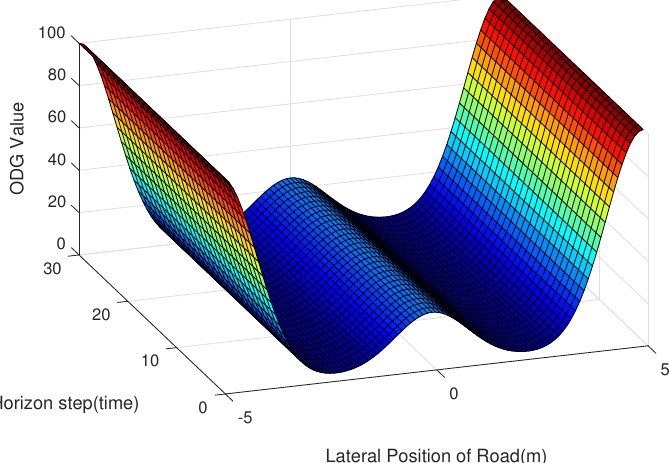
Figure 11. Line obstacle-dependent Gaussian (ODG) with model prediction control (MPC) longitudi- nal